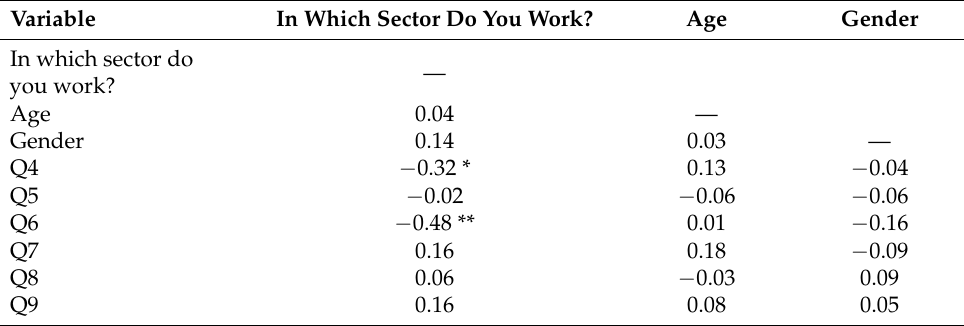
Table 3. Kendall’s τ correlations concerning demographical data of physical therapists involved in the C.A.L.A.B.R.I.A. study ( n = 80). Variable In Which Sector Do You Work?